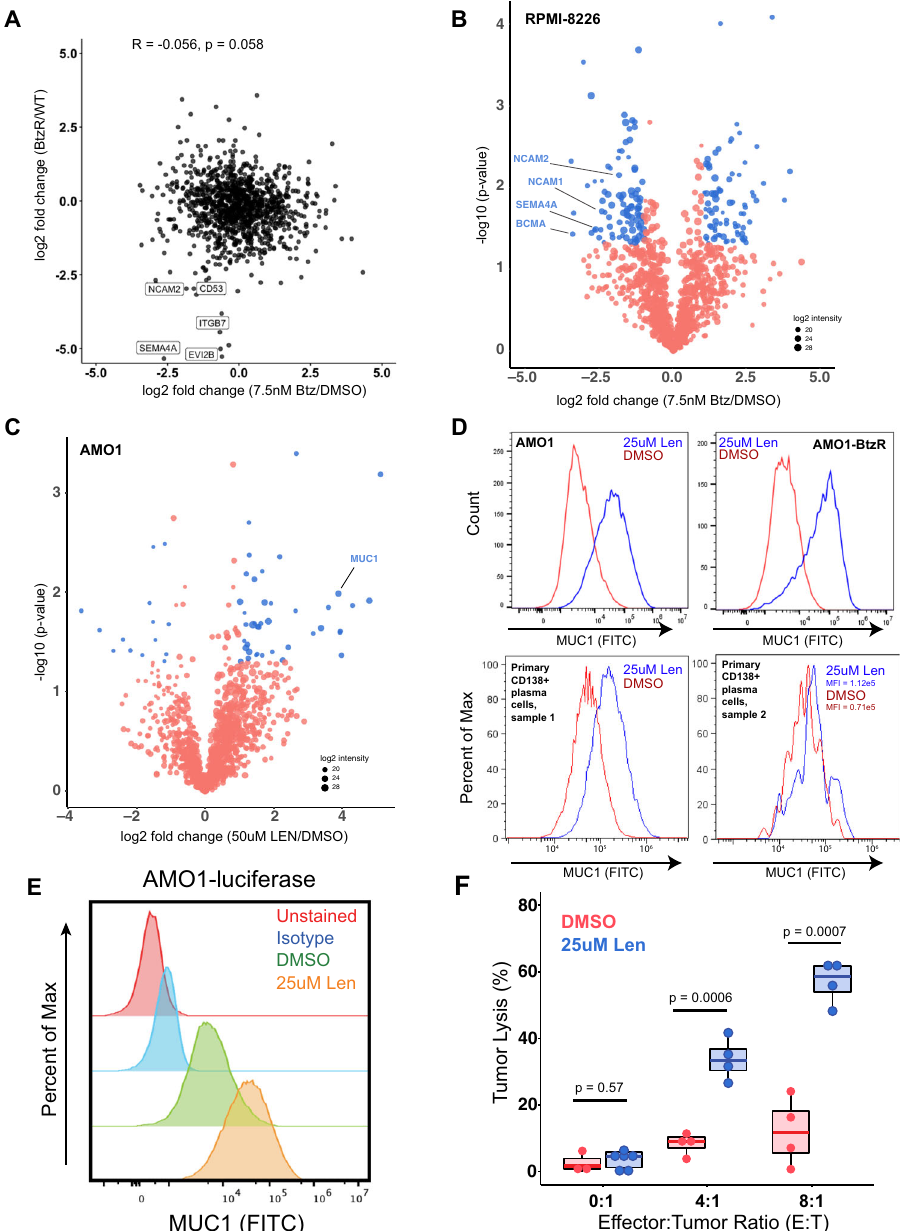
Fig. 5 Characterizing myeloma surface proteomic changes in response to acute drug treatment. A Correlation in surface proteomic pro fi le between acute Btz treatment in RPMI-8226 cells (7.5 nM, 48 h, n = 3 biological replicates) vs. DMSO ( n = 4 biological replicates) and aggregate BtzR cell line data (as in Fig. 3A) vs. parental. Common changes are observed in some downregulated surface proteins but no signi fi cant overall correlation is observed. Pearson correlation and associated p -value of signi fi cance shown. Source data in Supplementary Data 3 and 5. B Volcano plot of RPMI-8226 cells treated for 48 h with 7.5 nM bortezomib, highlighting signi fi cantly changed proteins (log 2 -fold change > |1|; p < 0.05 in blue). n = 3 biological replicates. C Similar plot as in B , for 48 h treatment with 50 μΜ Lenalidomide in AMO1 cells. n = 3 biological replicates. For B , C , source data in Supplementary Data 5. D Validation of increase in surface MUC1 in plasma cells in response to 25 μ M Lenalidomide treatment, in both AMO1, AMO1 BtzR, and CD138 + myeloma cells in two patient bone marrow aspirates. All plots representative of n = 3 (cell line) or n = 2 (primary sample) technical replicates. E MUC1 expression on cells treated with DMSO or Lenalidomide prior to incubation with anti-MUC1 CAR-T cells (representative of n = 2 independent experiments). F Percent tumor lysis of AMO1-luciferase cells after incubation with Anti-MUC1 CAR-T cells after 72 h, as measured by luminescence. Anti-MUC1 CAR-T cells more ef fi ciently kill cells pre-treated with lenalidomide, while lenalidomide alone has no cytotoxicity ( n = 4 technical replicates for E:T = 4:1 and E:T = 8:1, n = 8 technical replicates for E:T = 0:1, p -values by Student ’ s t -test). Source data are provided as a Source data fi le. Upper and lower hinges correspond to 25 and 75 percentiles, upper and lower whiskers extend to highest and lowest values, and center line indicates the